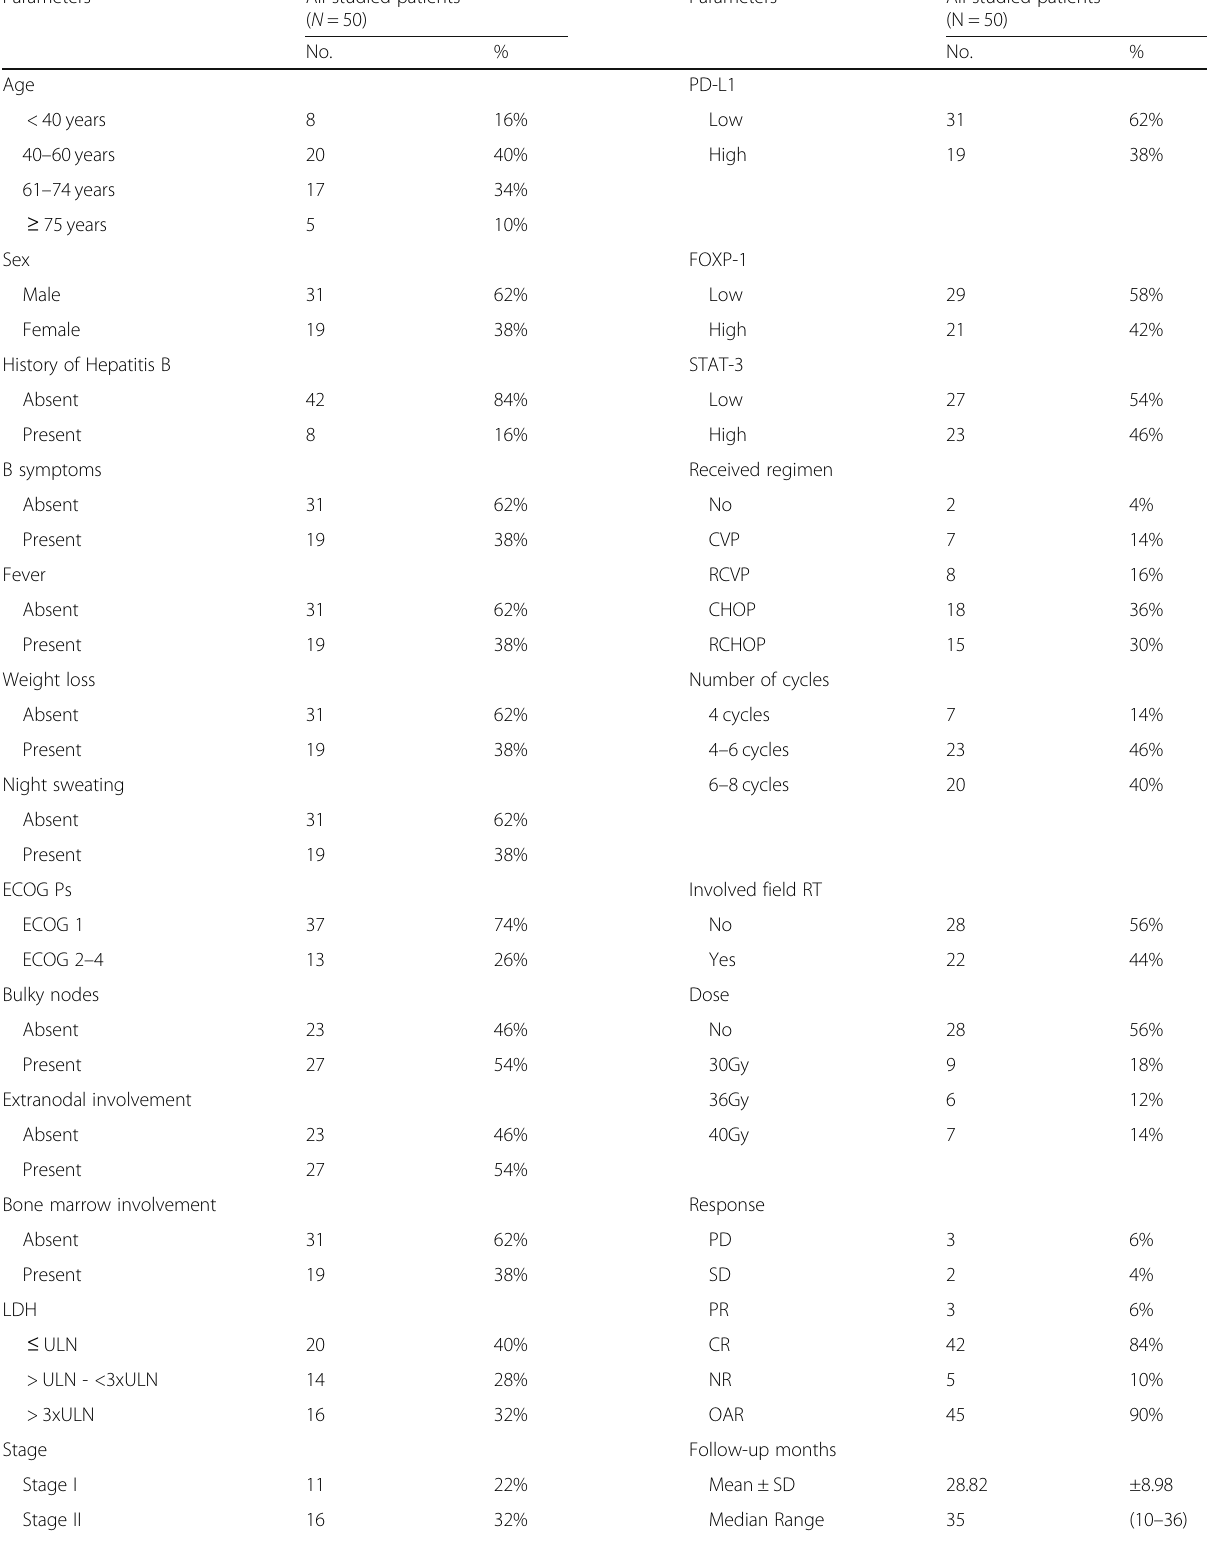
Table 1 Clinicopathological features, PDL1, FOXP1, STAT3 expression and outcome of our